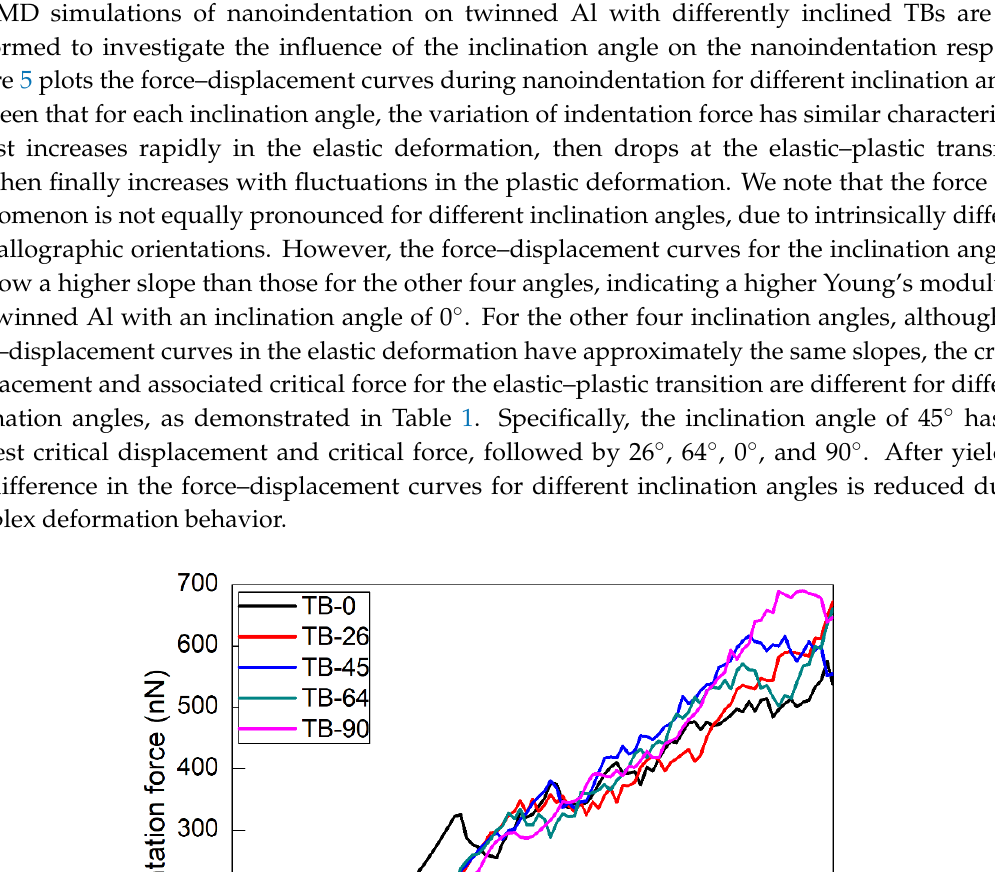
Figure 4. Representative dislocation–TB interactions. Displacement: ( a ) 0.88 nm; ( b ) 1.6 nm. Atoms are colored according to their CNA values, and perfect face-centered cubic (FCC) atoms are not shown.